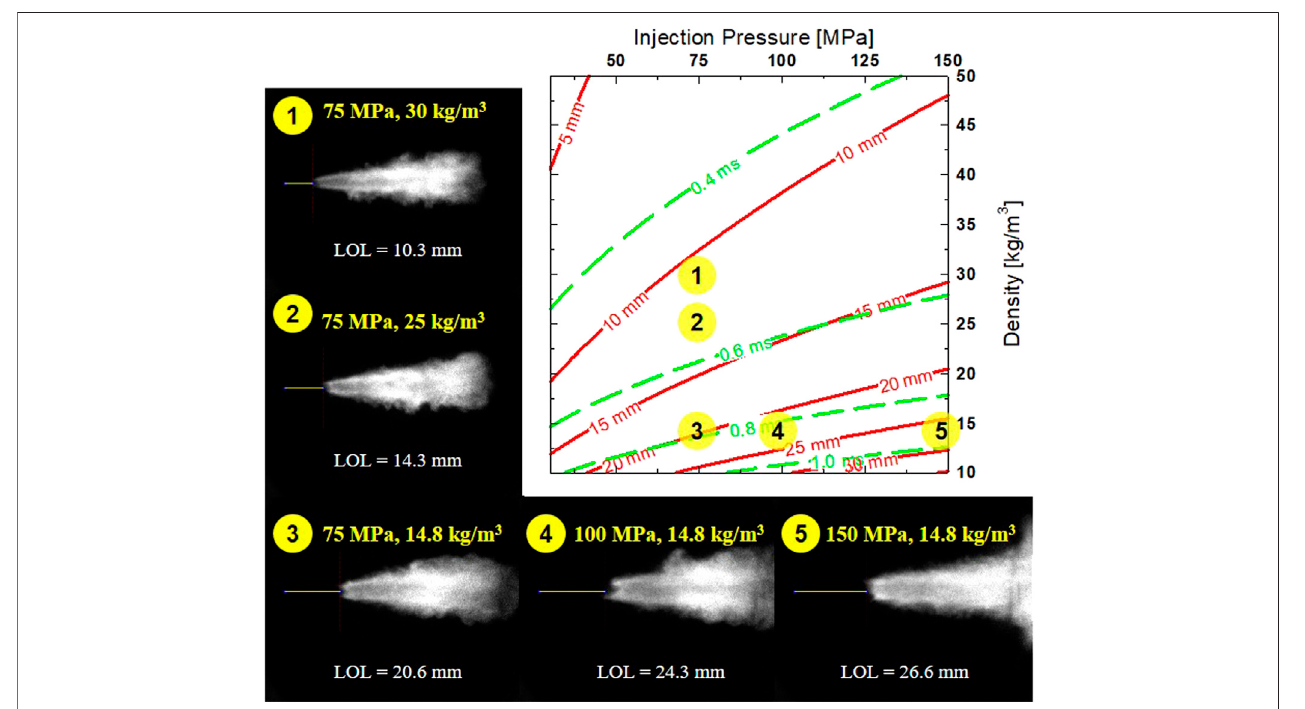
FIGURE7| CalculatedLOLwithdifferentP inj and ρ amb atsimilarT amb (cid:1) 900 K,O 2 (cid:1) 18%.ExampleOH*imageshownforeachcorresponding(numbered)condition of P inj and ρ amb .